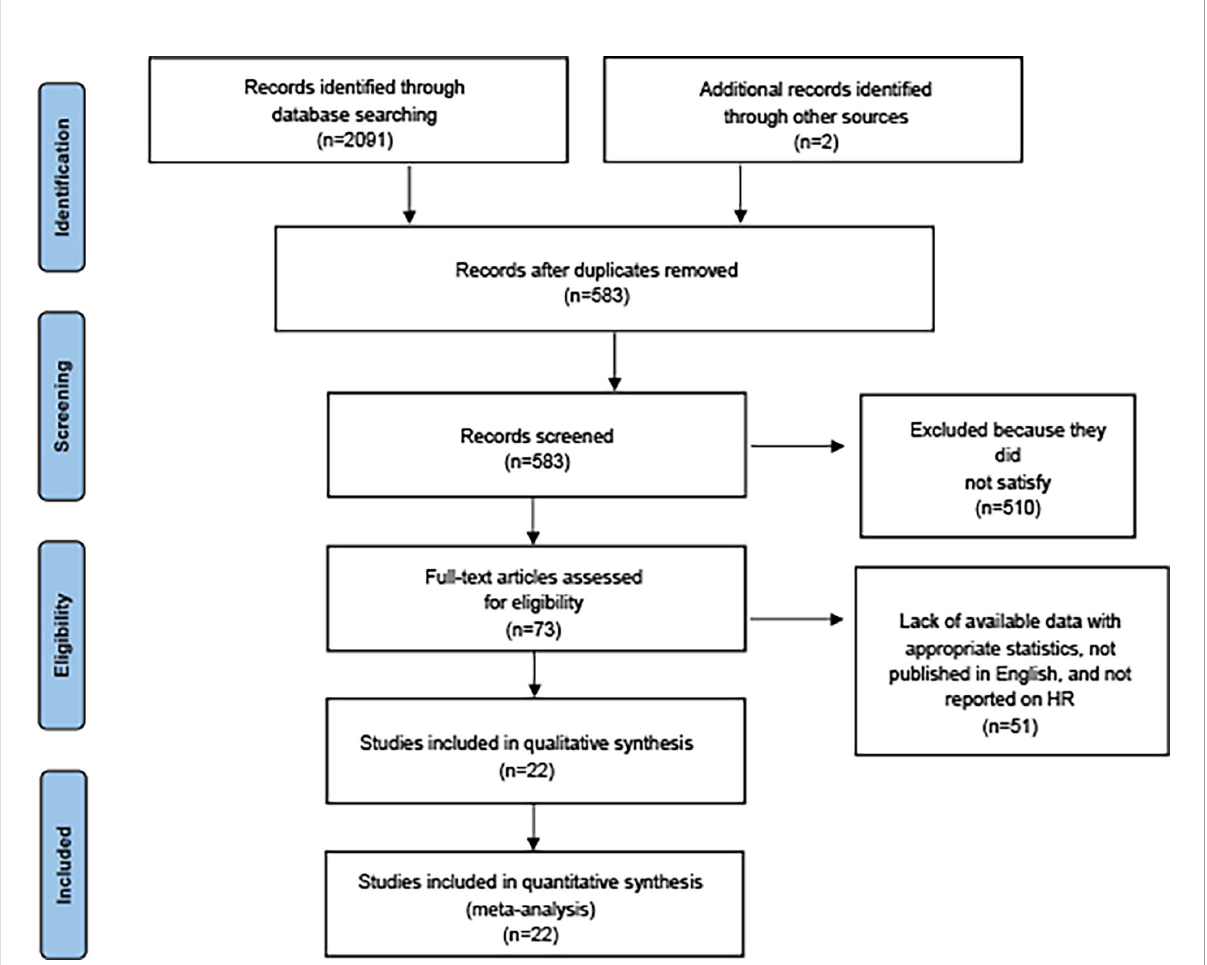
FIGURE 1 PRISMA diagram of study selection (available at https://prisma-statement.org/prismastatement/ fl